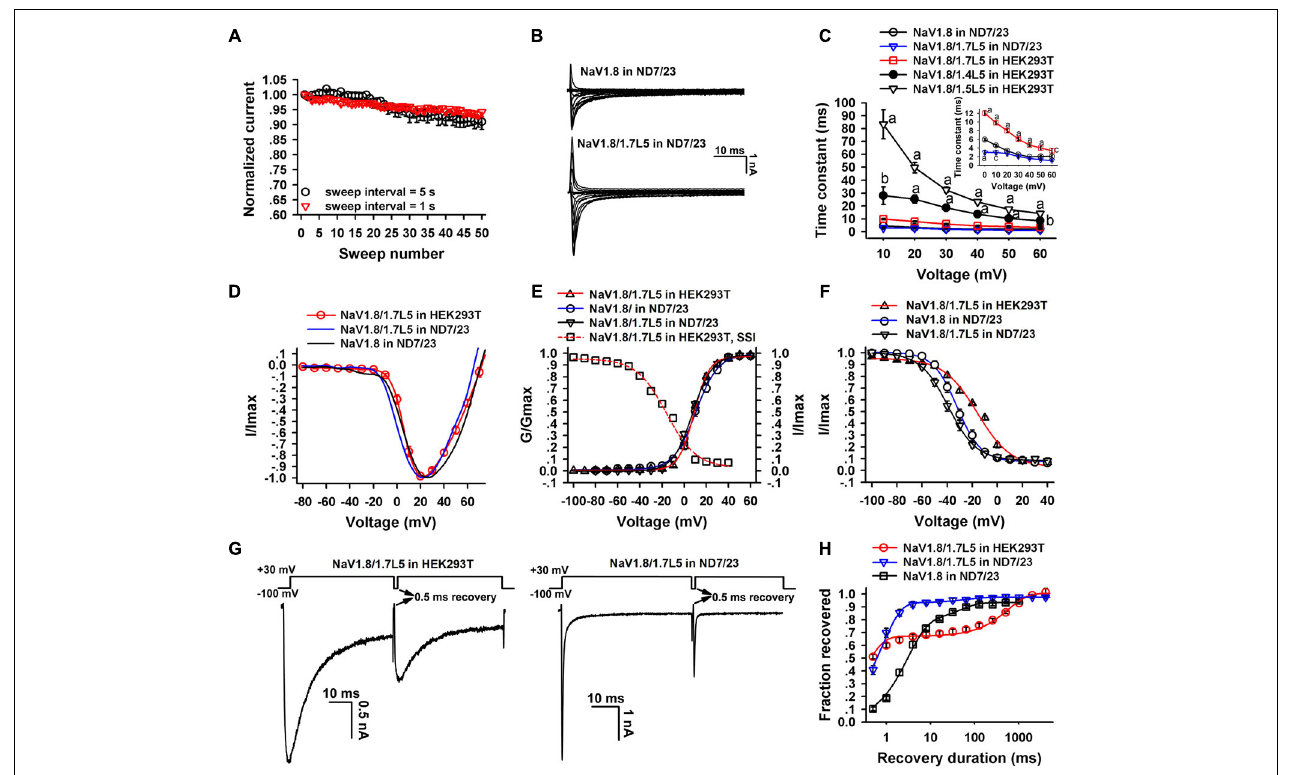
FIGURE 3 | Electrophysiological properties of NaV1.8/1.7L5. (A) NaV1.8/1.7L5 currents in repetitive depolarizations. Currents elicited by 50 consecutive depolarizations to +10 mV were normalized to that of the first one, sweep interval was set to be 1 s (red triangel) or 5 s (black circle), n = 9 – 10. (B) Representative current traces of NaV1.8/1.7L5 and NaV1.8 expressed in ND7/23 cells. (C) The decay time constants of channels as shown, at the depolarizing voltages from 10 to 60 mV (a, b and c represented p < 0.001, p < 0.01, and p < 0.05, respectively; inset was an enlarged view of NaV1.8 and NaV1.8/1.7L5 traces; n = 15 in each group). (D) , I – V relationships for NaV1.8/1.7L5 expressed in HEK293T (red) or ND7/23 (blue) cells, and NaV1.8 expressed in ND7/23 cells (black), n = 9 – 14. (E,F) Steady-state activation and inactivation relationships of NaV1.8/1.7L5 expressed in HEK293T cells or ND7/23 cells, and NaV1.8 expressed in ND7/23 cells.